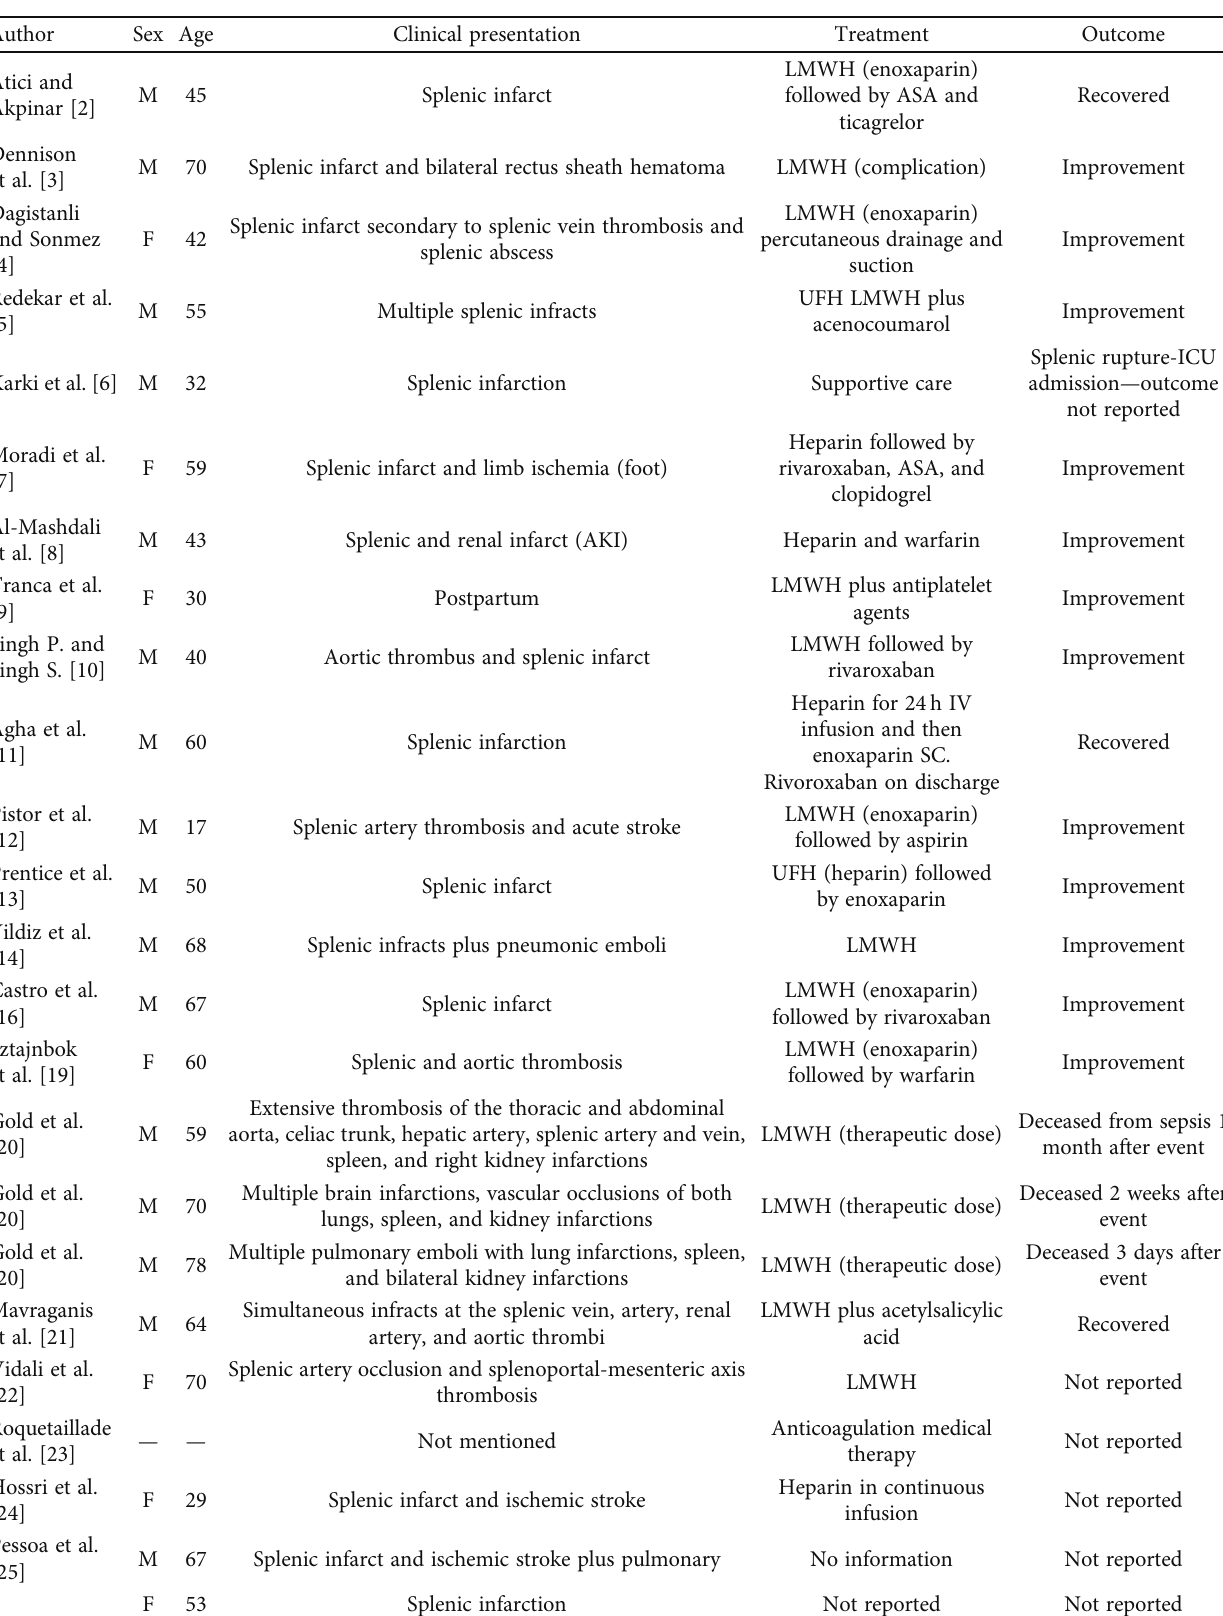
Table 2: Literature review of cases of COVID-19 with splenic